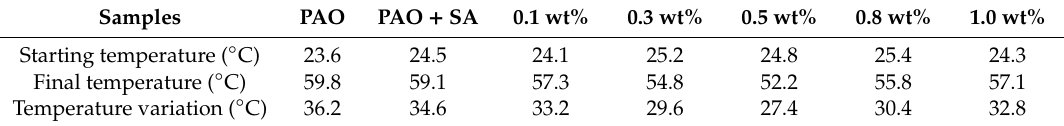
Figure 7. The SEM images of wear scars lubricated by di ff erent lubricating samples under four-ball test condition. ( a ) PAO; ( b ) PAO + SA + 0.3 wt% AgReO 4 ; ( c ) PAO + SA + 0.5 wt% AgReO 4 ; ( d ) PAO + SA + 1.0 wt% AgReO 4 . Table 2. The temperature rising of di ff erent lubricating samples after the four-ball test.